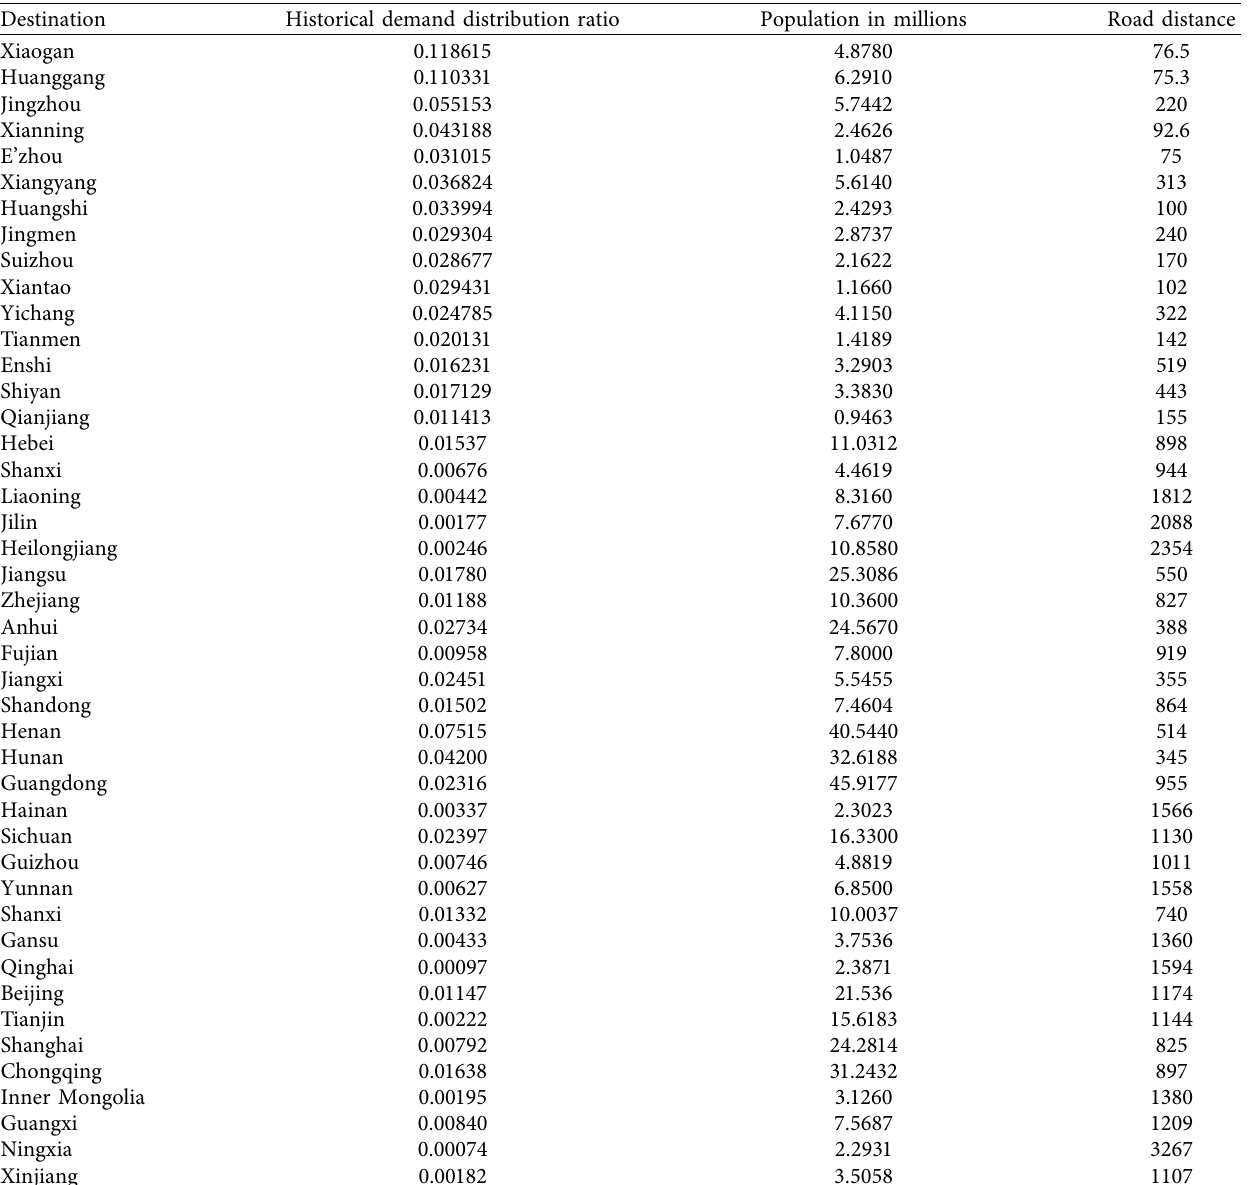
Table 4: The historical demand distribution data, the population of cities and provinces, and the road distance from Wuhan to other destination